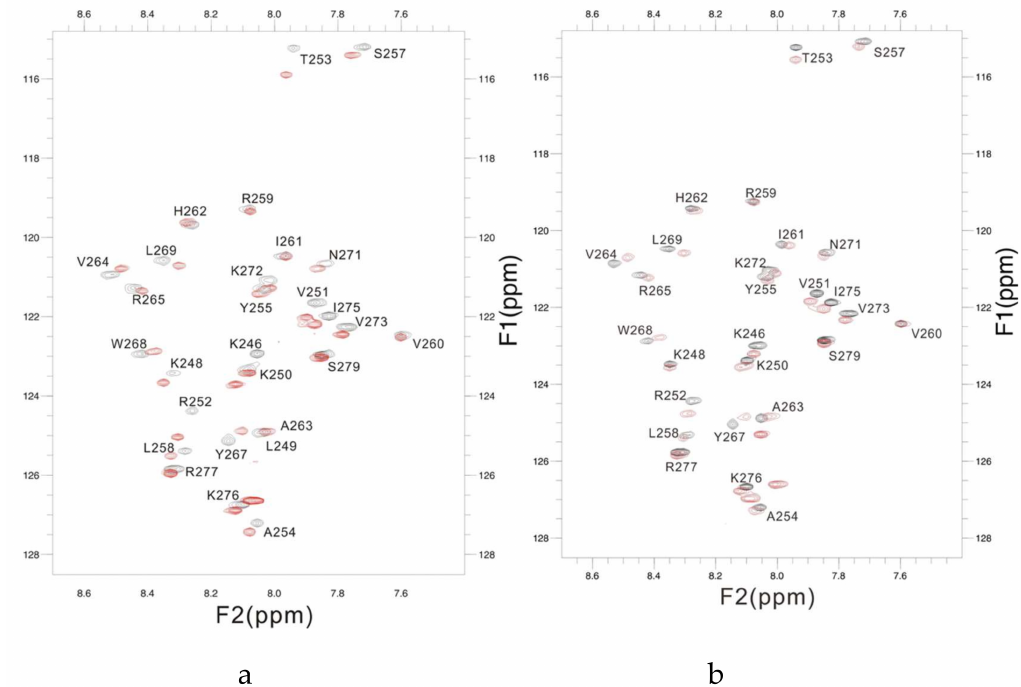
Figure A1. The overlaid 1 H- 15 N HSQC spectra of PSTD of ST8Sia IV in the absence (black) and presence (red) of 1 mM ( a ) and 1mM DP3 ( b ).